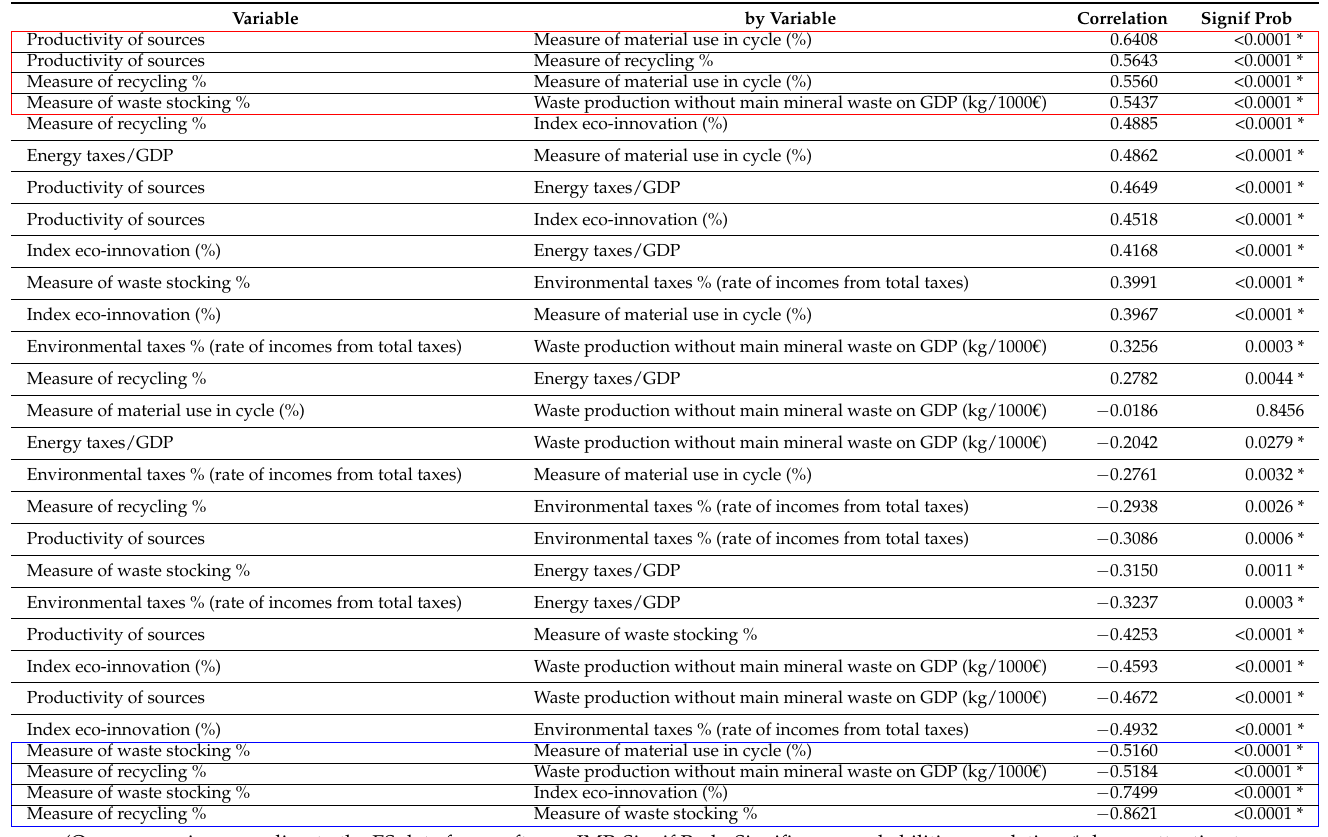
Table 3. Results of pair correlation of